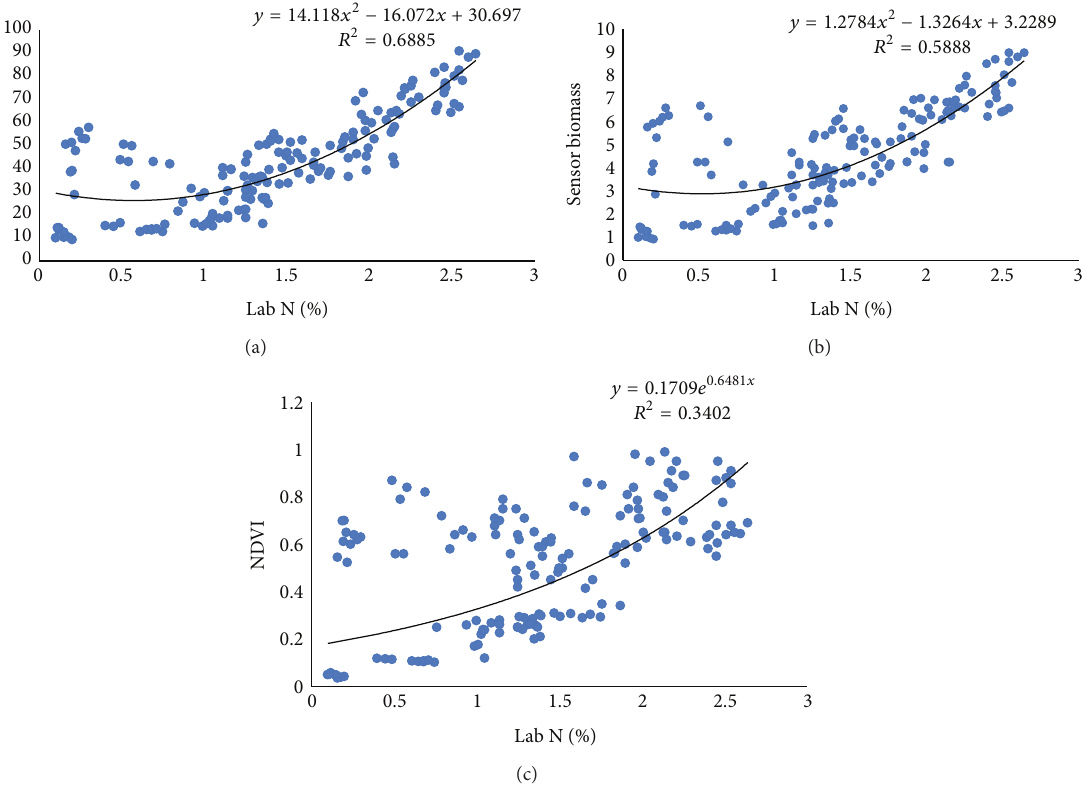
Figure 12: Correlations between different N-sensor attributes and Lab N for complete crop